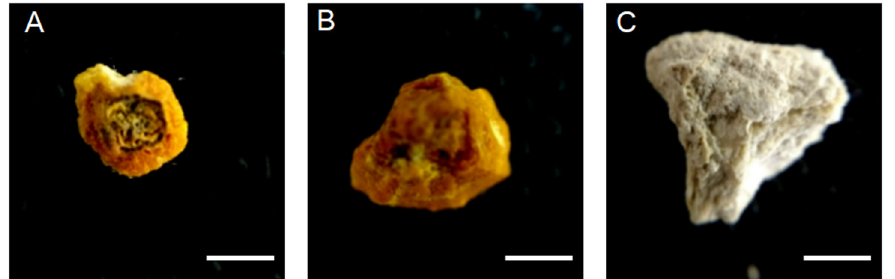
Figure 1. Samples of the renal stones obtained from patients with nephrolithiasis through conventional percutaneous nephrolithotomy. ( A ) Cortex. ( B ) Middle. ( C ) Nucleus. Scale bar: 3 mm.